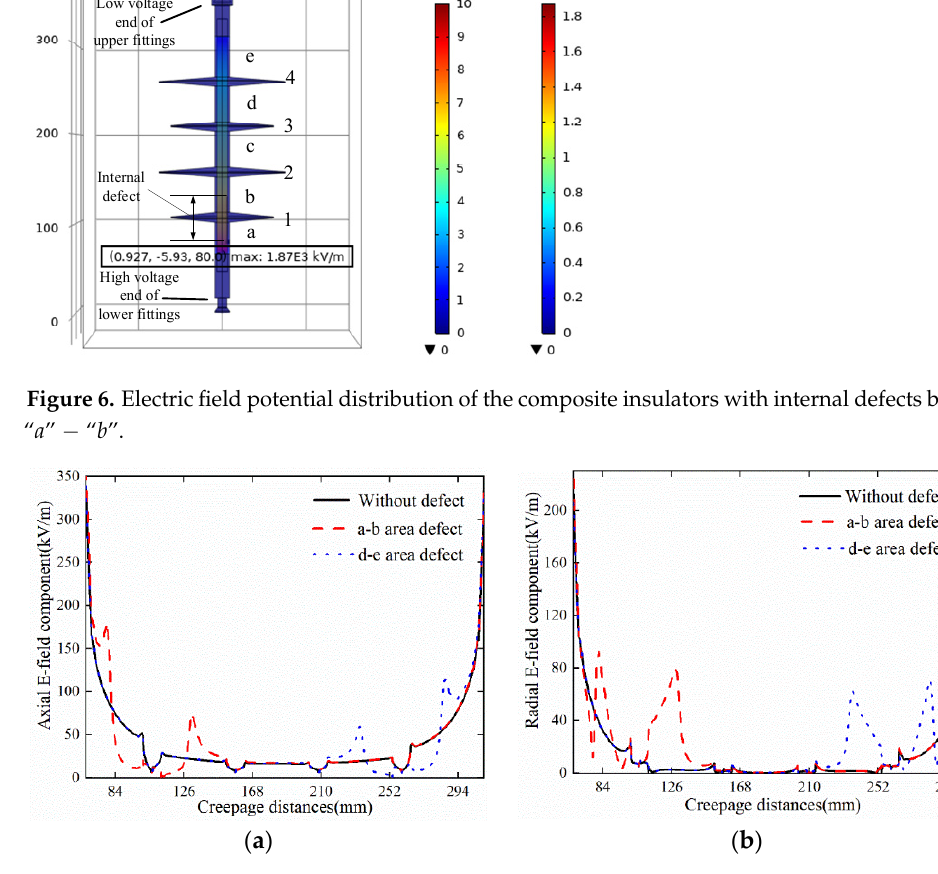
Figure 7. Distribution curves of the surface of the composite insulator with internal defects: ( a ) axial electric field; ( b ) radial electric field.